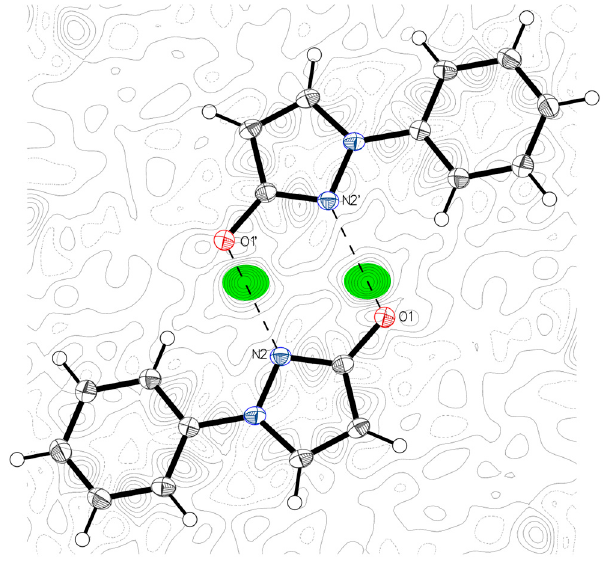
Figure 2. Difference electron density map of 1 . Determination of the H position at O1. The distance of O1 to the electron density position (green shaded) in the direct donor acceptor line is 0.8927 (10) Å. The according distance to N2 ′ is 1.8339 (10) Å. For further details please follow the CCDC Code.